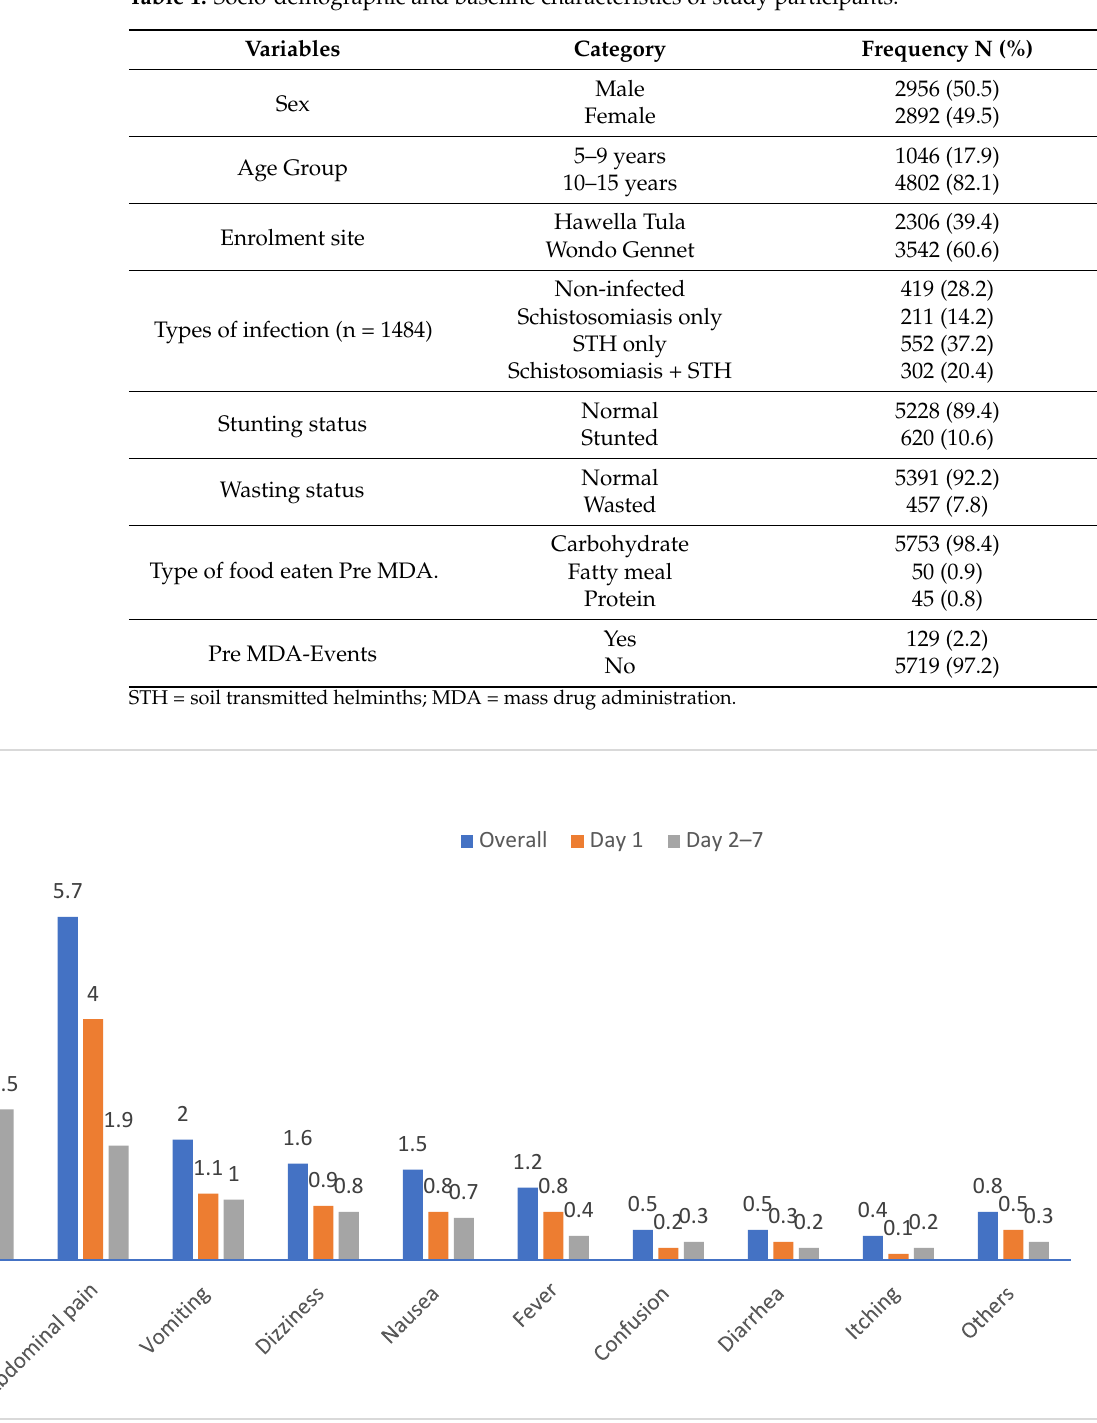
Figure 2. Cumulative incidence of AEs and stratified by days of follow-up.